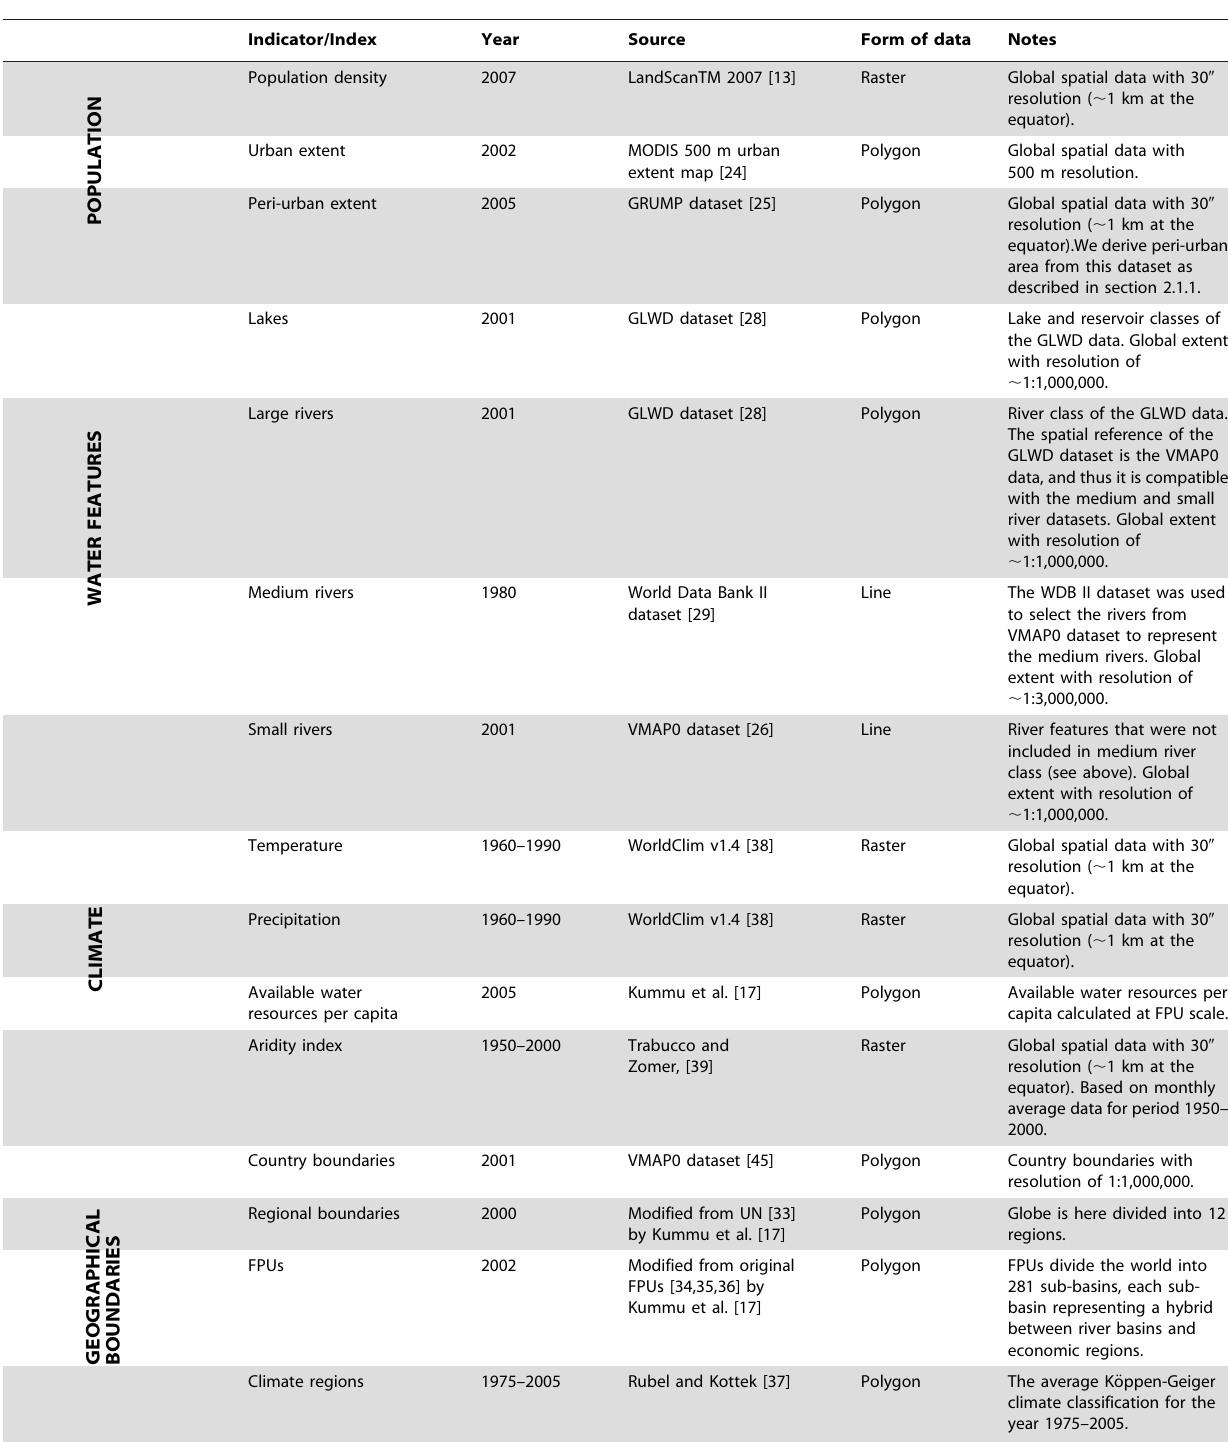
Table 1. List of the spatial data used in the analyses with source and form of